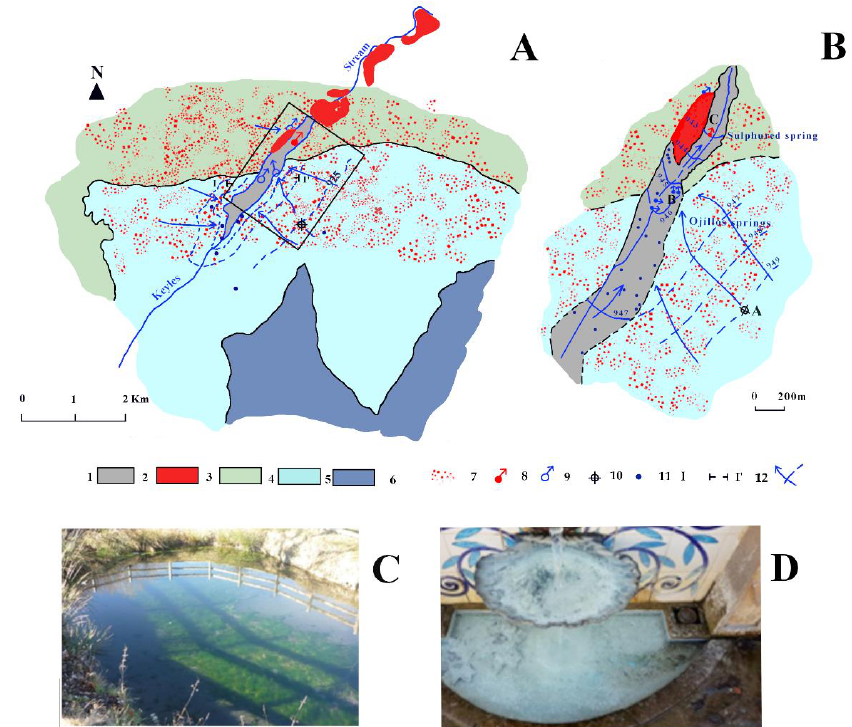
Figure 3. ( A ) Aquifer of Los Ojillos del Keyles springs, Á greda hydrogen sulphide spring, and deposits of filamentous sulphates. ( A ) Location of Los Ojillos del Keyles springs and the Á greda sulphur source. ( B ) Detail of study area. ( C ) Los Ojillos del Keyles spring. ( D ) Á greda sulphur source and filamentous sulphur deposits. (1) Quaternary aquifer with organic sediments. (2) Calcareous tuffs. (3) Tera group of Weald facies. (4) Limestones. (5) Marly limestones and marls. (6) Pyrite mineralisations. (7) Hydrosulphide spring of Agreda. (8) Los Ojillos del Keyles springs. (9) Agreda supply well. (10) Water points. (11) Hydrogeological cut. (12) Equipotential and streamlines.